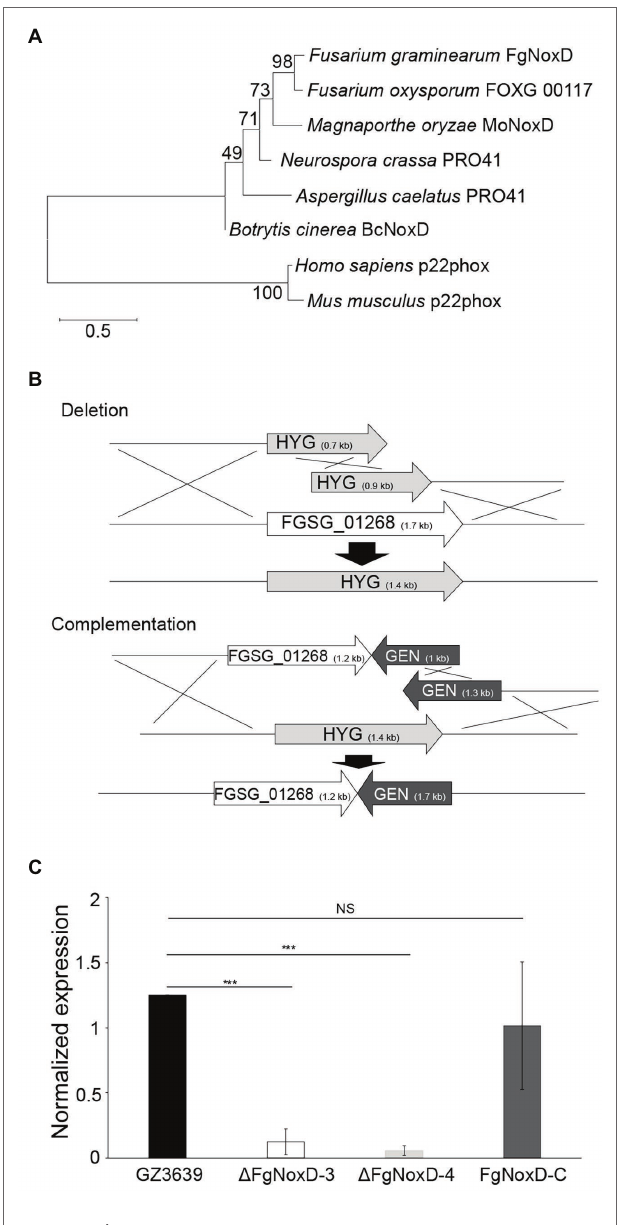
FIGURE 1 | FgNoxD amino sequence phylogenetic tree and gene manipulation. (A) Phylogenetic analysis of FgNoxD protein. All amino acid sequences were aligned using ClustalW which built-in MEGA X (version 6.0). The phylogenetic tree analyses were performed using the method of Maximum likelihood (ML). (B) Homologous recombination for construction of FgNoxD deletion and complementation constructs. Complementation strain was created using the Δ FgNoxD-3. (C) Relative expression levels of FgNoxD in GZ3639, Δ FgNoxD, and FgNoxD-C. Error bars indicate standard errors from four repeated experiments with three biological replications. Asterisks indicate value of p (NS, no significance; *** p < 0.001) after comparison with Welch’s t -test. HYG, hygromycin resistance cassette and GEN, geneticin resistance